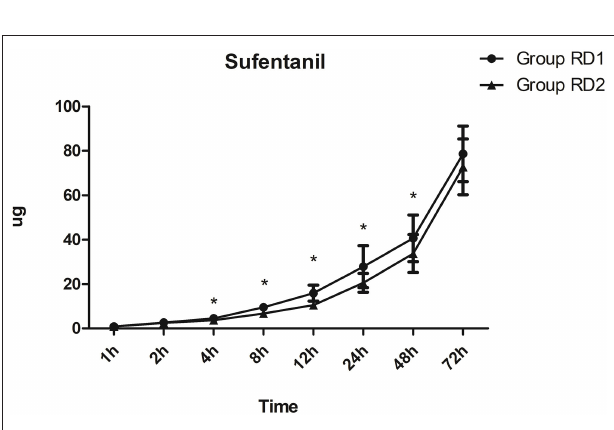
FIGURE 4 | Postoperative sufentanil consumption in the two groups. * P < 0.05 vs. RD1